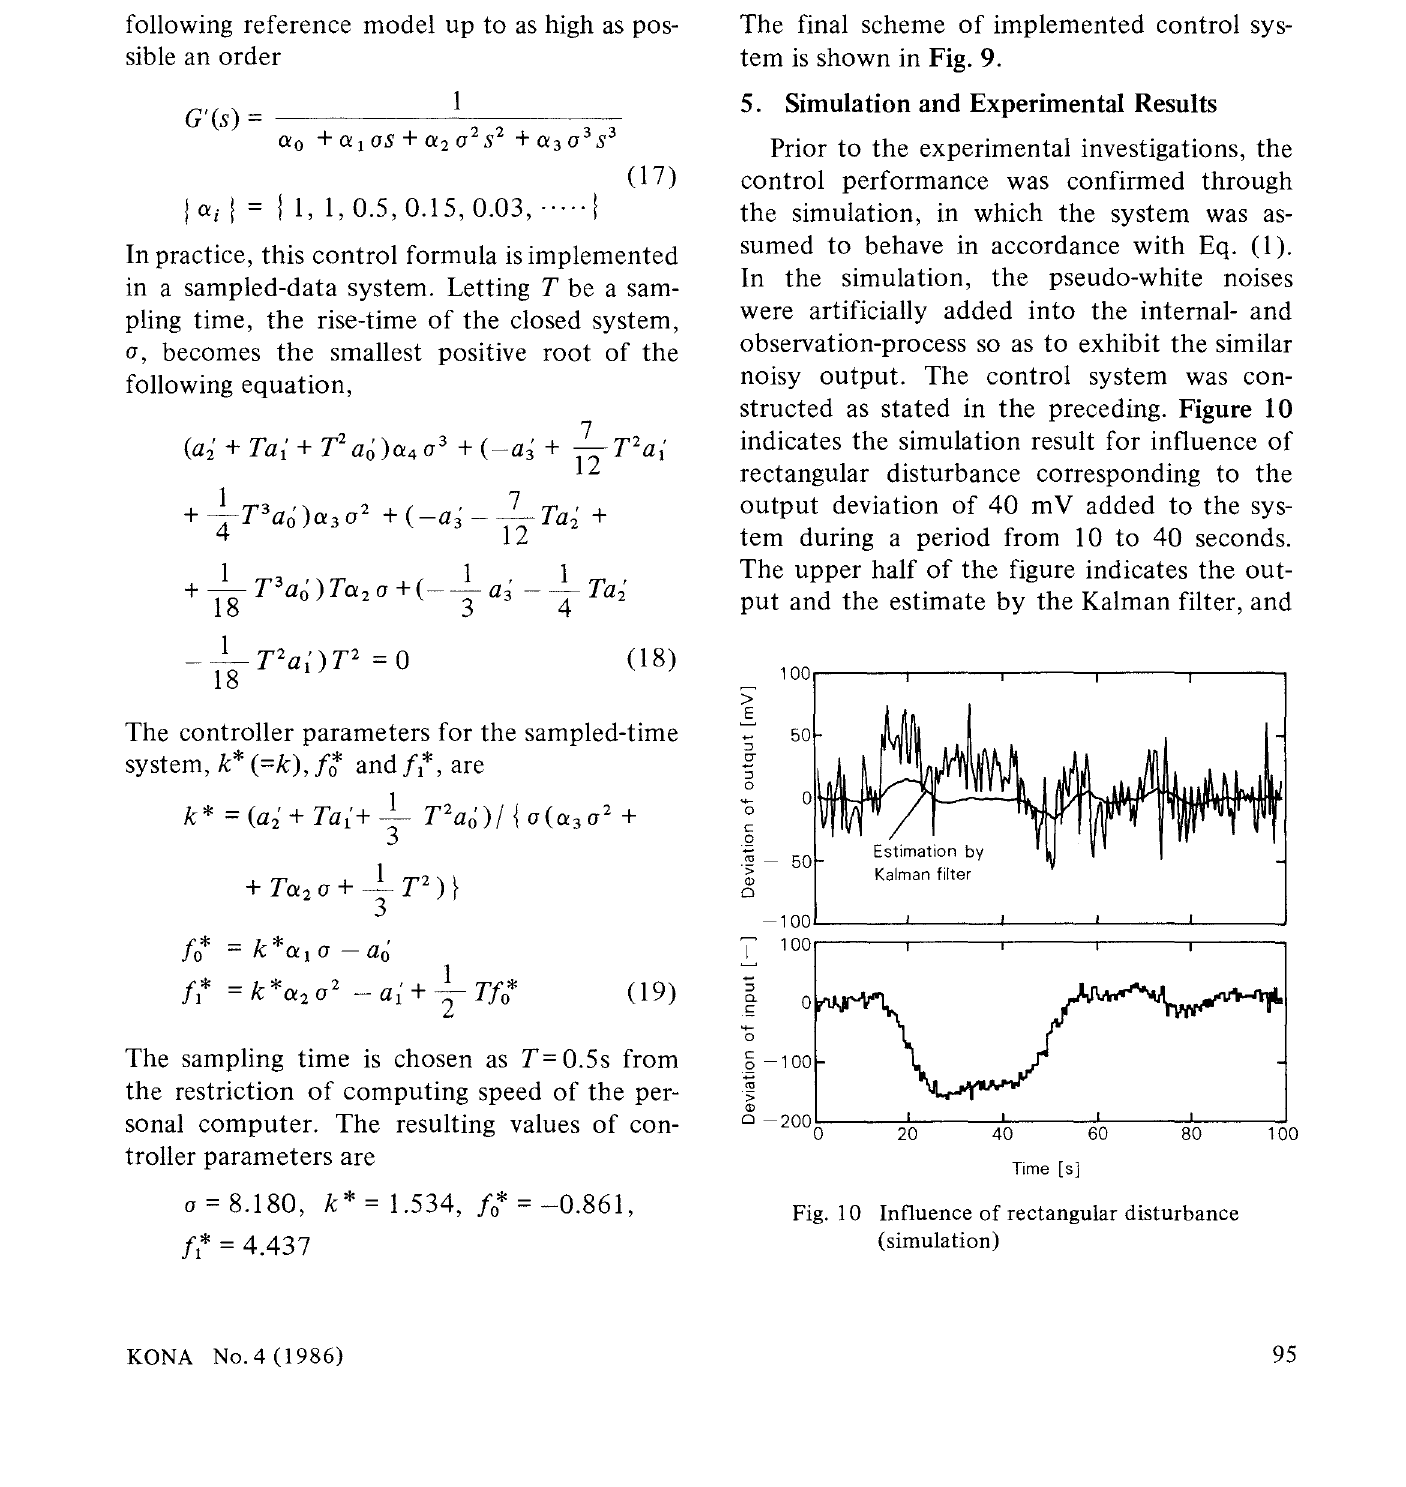
Fig. 1 0 Influence of rectangular disturbance